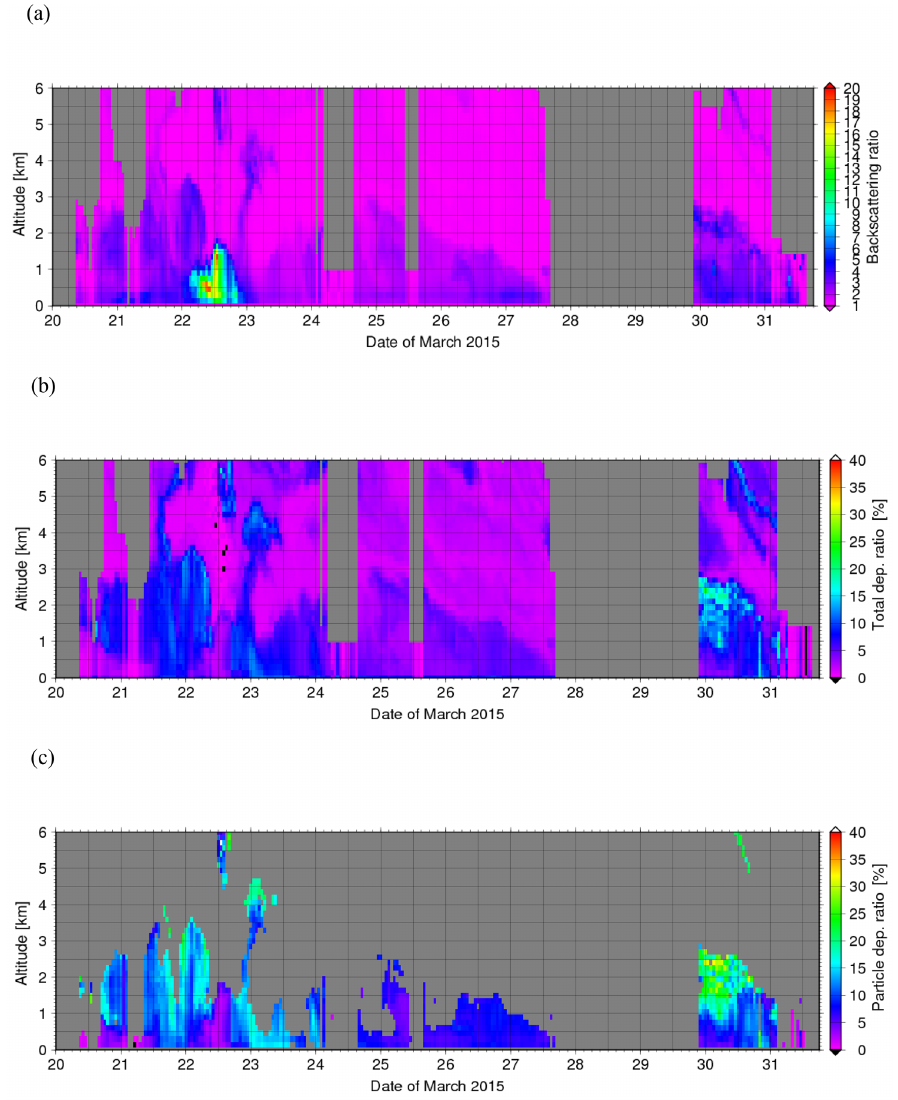
Figure 3. Time–altitude cross sections of (a) backscattering ratios, (b) total volume depolarization ratios, and (c) particle depolarization ratios for R ≥ 2.0 at 532nm observed by Mie lidar at Saga from 09:24JST on 20 March to 14:34JST on 31 March 2015. Lidar observations were not available from 15:56JST on 27 March to 21:58JST on 29 March 2015 mainly because of rainy or cloudy conditions. Gray regions are areas where there were no observational data or where the observations were affected by